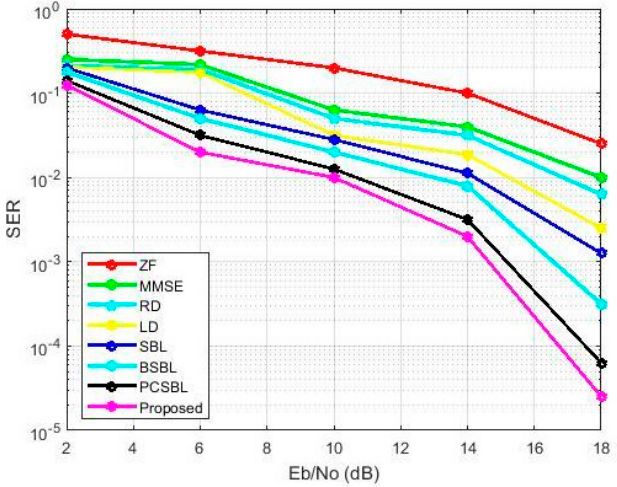
Figure 3. Performance of SER vs. SNR (dB) with 100 users. Technologies 2018 , 6 , x FOR PEER REVIEW